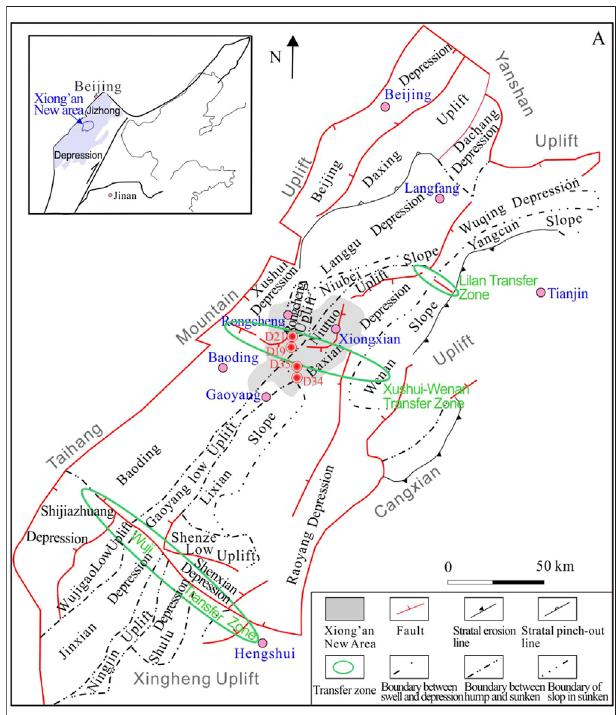
FIGURE 1 | Structural location of the Xiongan New Area in Jizhong